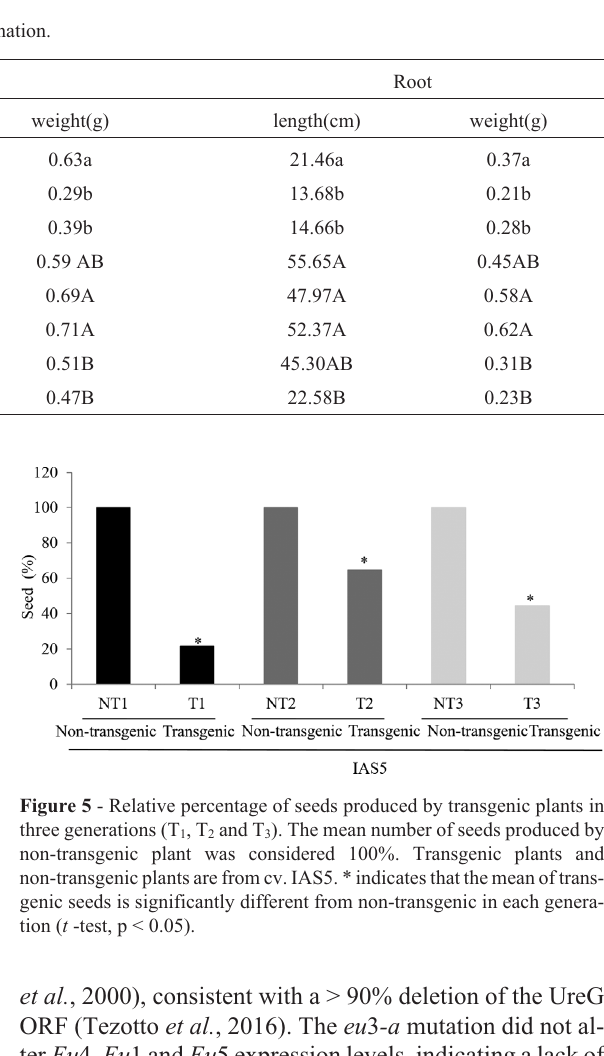
Figure 4 - Nitrogen content rate in shoot of soybean at one month after germination.(A)Transgenicandnon-transgenicplantswereevaluated:18 plants derived from each event (A3 and A8) and 10 non-transgenic plants. (B) eu4-a, eu1-a, eu1-a/eu4-a and eu3-a mutant and non-mutant plants were evaluated: 18 plants from each mutant and 10 non-mutant plants. ANOVA, p < 0.0001. Means followed by the same letter did not differ by Tukey’s post hoc